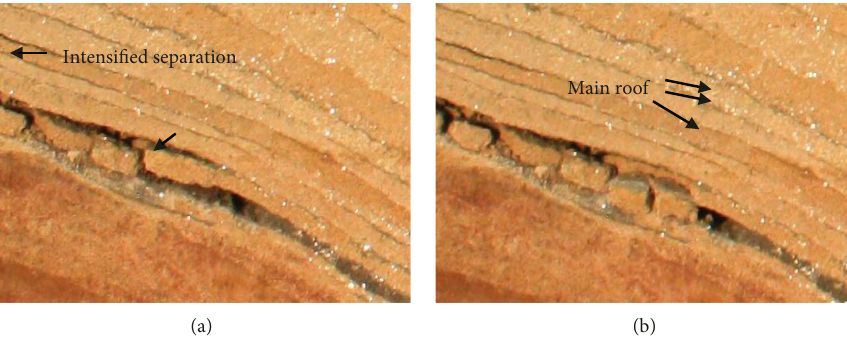
Figure 5: Activity of overlying strata. (a) Separate fractures. (b) The position of the main